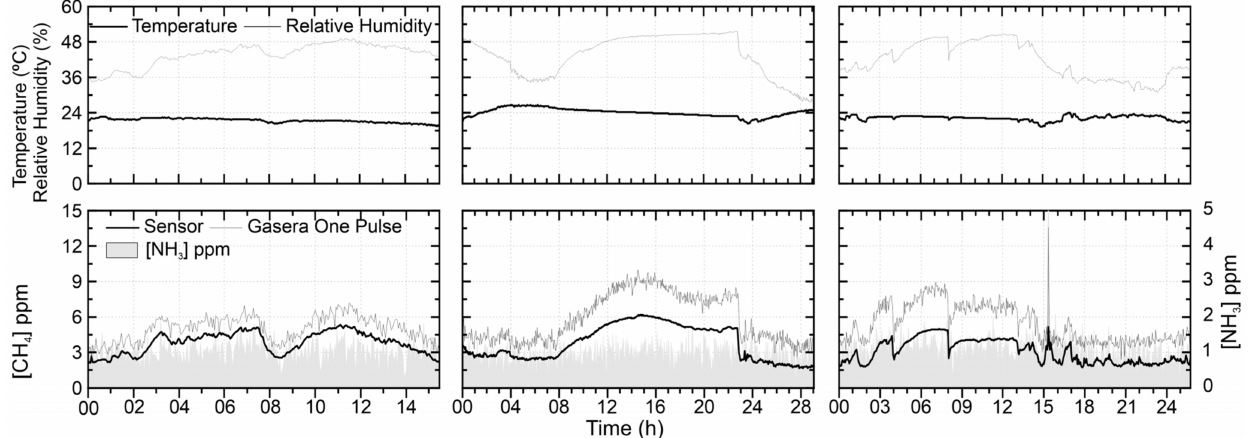
Figure 14. TGS2600 test on 2, 10 and 13 October 2020 performed indoors at the laboratory and